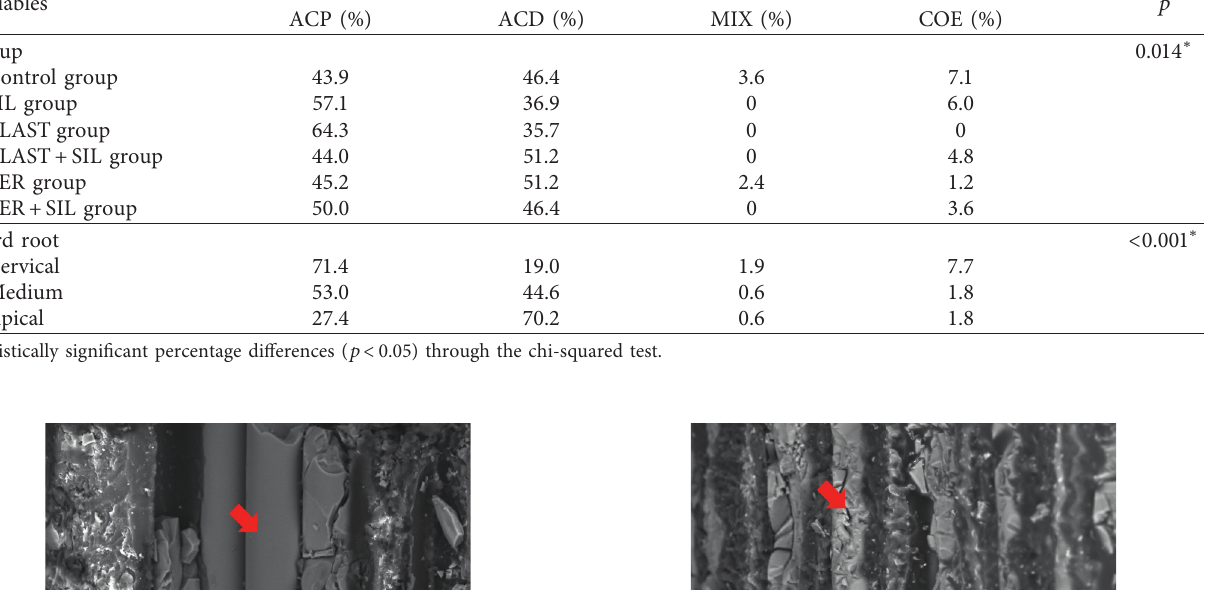
Table 3: Percentage distribution of the fracture pattern by the group and by evaluated third root. Variables